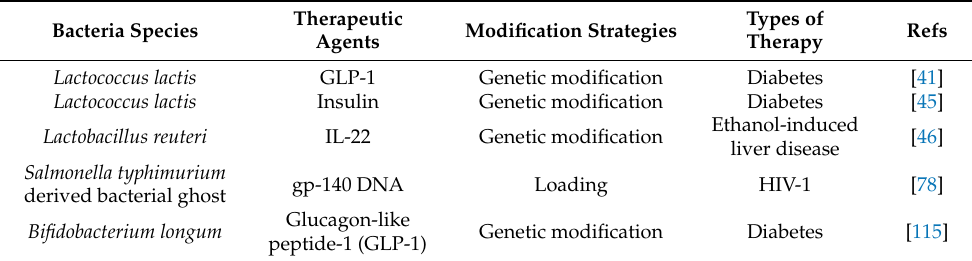
Table 3. Therapeutic biomacromolecules based on oral bacterial microdevices for treating other